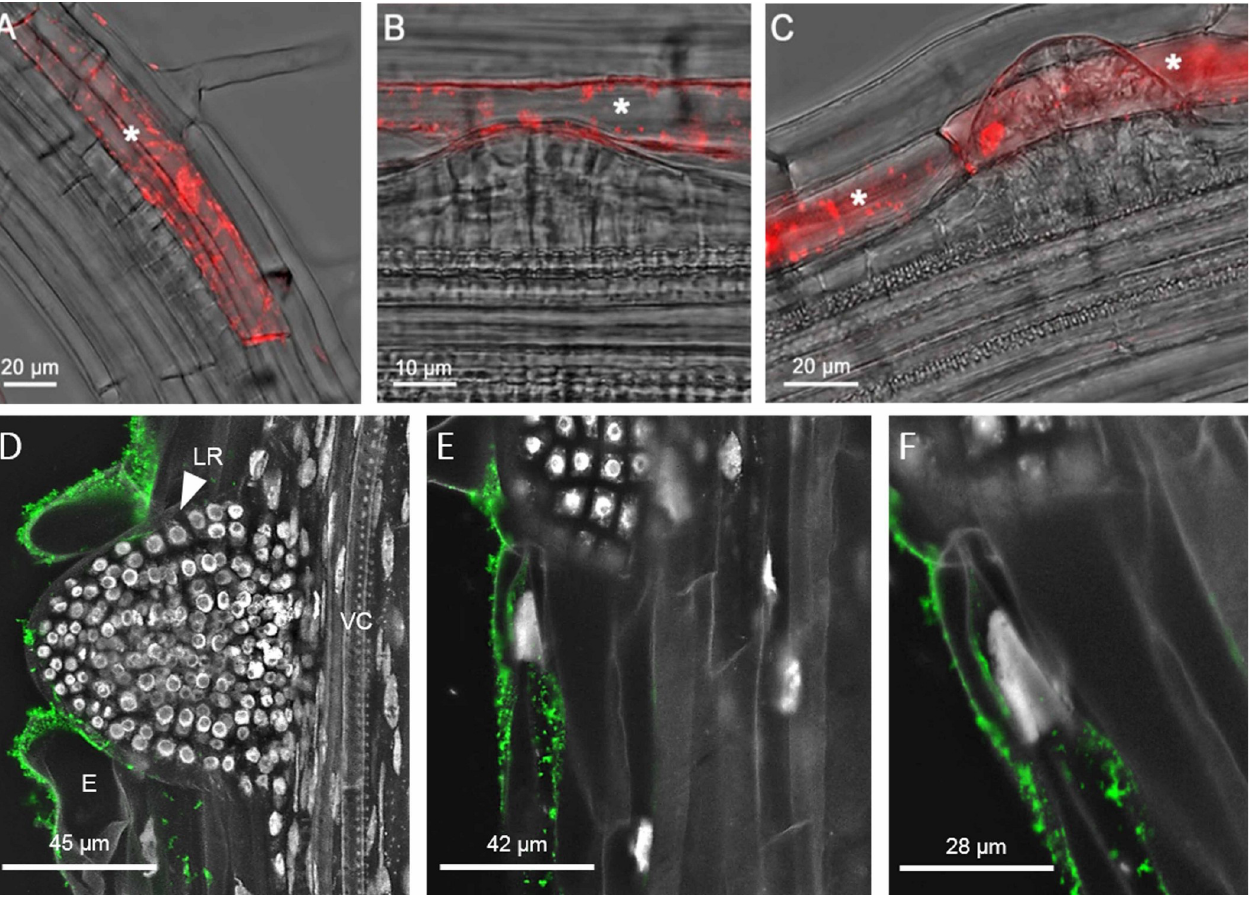
Fig 11. CEP2 is expressed in the root epidermis cells at lateral root (LR) emergence sites. (A-C) The eight stages (roman numbers, see S6 Fig) of LR primordium development in the roots of 10 day old WT seedlings expressing the pro-mCherry-CEP2 reporter under the control of the endogenous promoter ( P :: pre-pro-3xHA-mCherry-AtCEP2-KDEL ) were analyzed in vivo by CLSM (Leica SP8). (A) Stage I-VI of LR primordium development. (B) Stage VII of CEP2 LR primordium development. (C) Stage VIII of LR primordium development. The white asterisk indicates epidermis cells expressing pro-mCherry-AtCEP2 for LR emergence. (D-F) CEP2 was immunolocalized to epidermis cells that have to be moved for the emerging LR. (D) Maximum projection of LR emergence; LR, lateral root; VC, vascular cylinder; E, epidermis. (E) Single optical section shows CEP2 accumulation only in the epidermal cell bordering the LR outbreak. (F) Magnification of epidermal cell next to LR